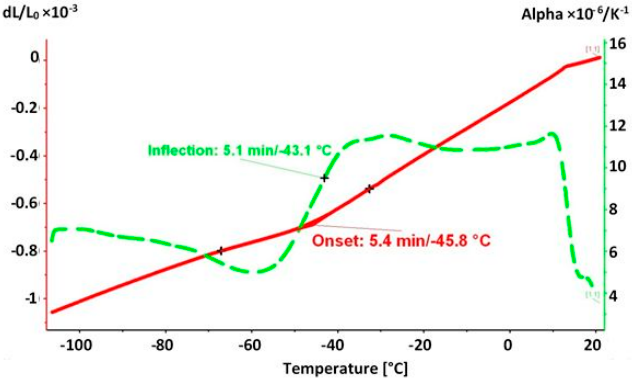
Figure 1. Dilatometry of Vanadis 6 steel after austenitizing at 1050 °C for 30 min, quenching to 20 °C, and cooling from 20 °C down to − 110 °C with a cooling rate of 10 K min − 1 .